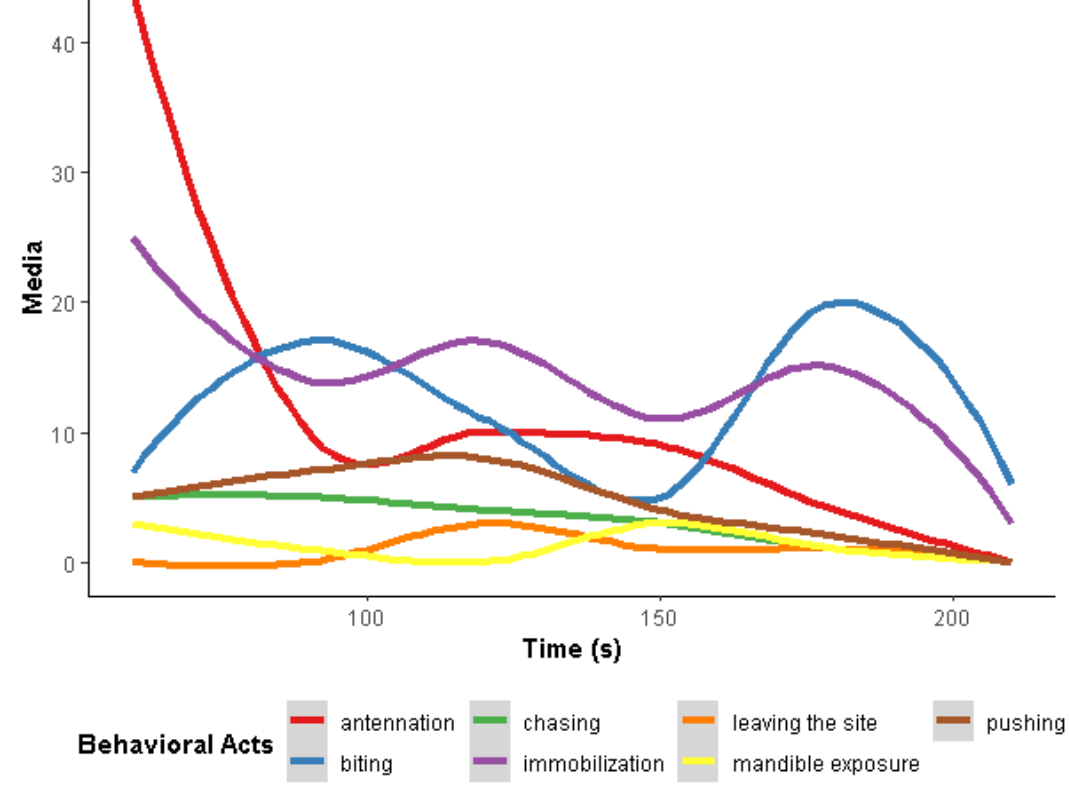
Fig 2. Difference between behavioral rates in intercolonial confrontations among Nannotrigona testaceicornis workers according to time.